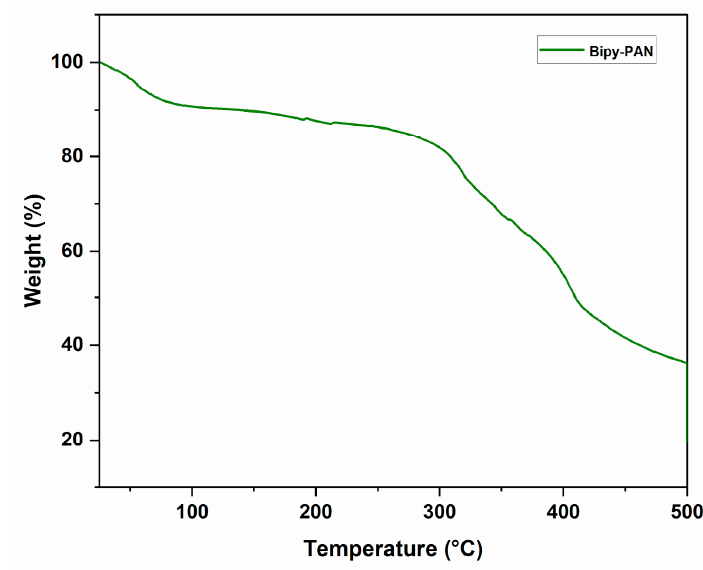
Figure 5. TGA curve of Bipy-PAN and air flow (10 °C/min).